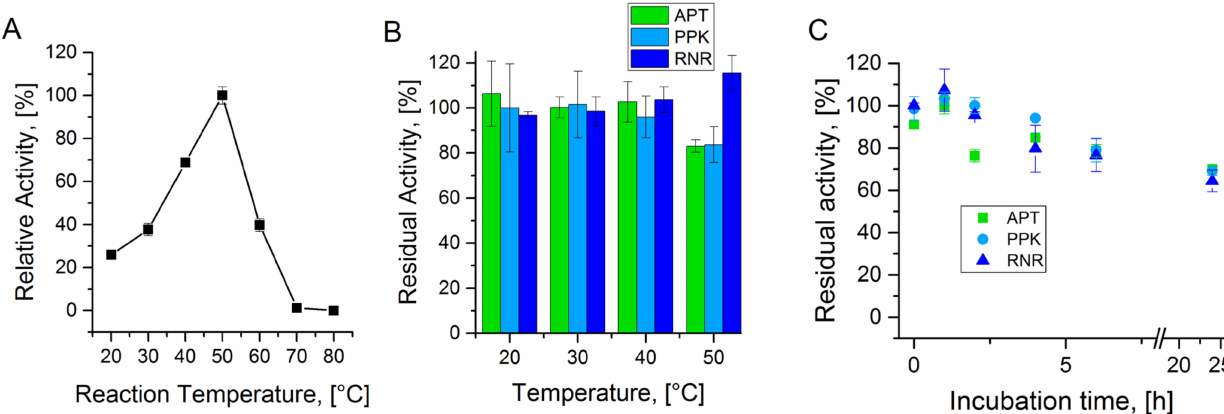
Figure A1. Enzyme temperature stability: ( A ) Relative activity of APT at a pH-value of 8.0 in a temperature range from 20 ◦ C to 80 ◦ C. ( B ) Residual activity of APT, PPK, and RNR after 1 h of incubation at the respective temperatures. ( C ) Residual activity of APT, PPK, and RNR after incubation at 40 ◦ C, measured at several time points up to 24